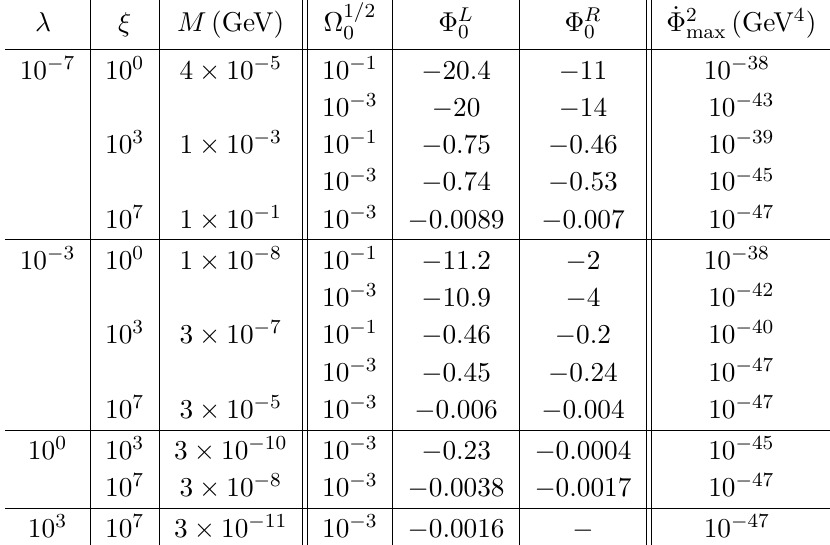
are the two initial positions 0 is the max